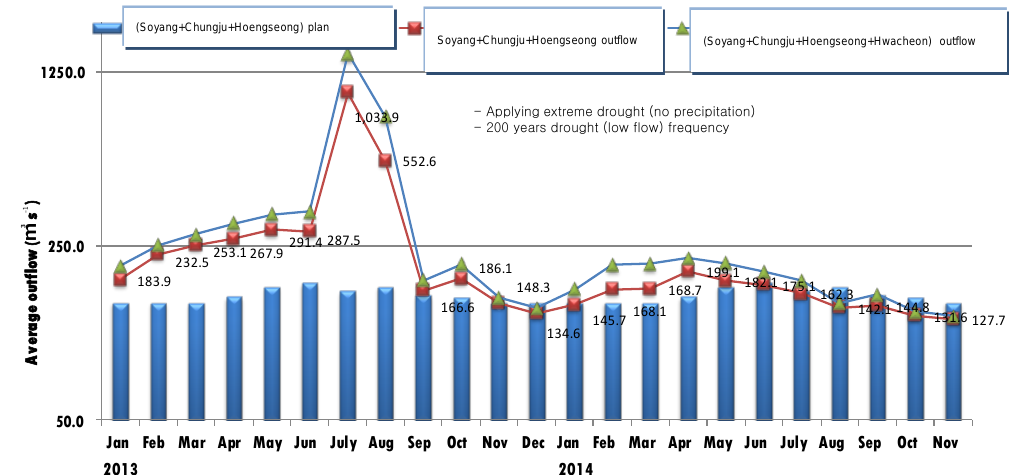
Figure 4. Providing real water demands by considering drought status and conjunctive